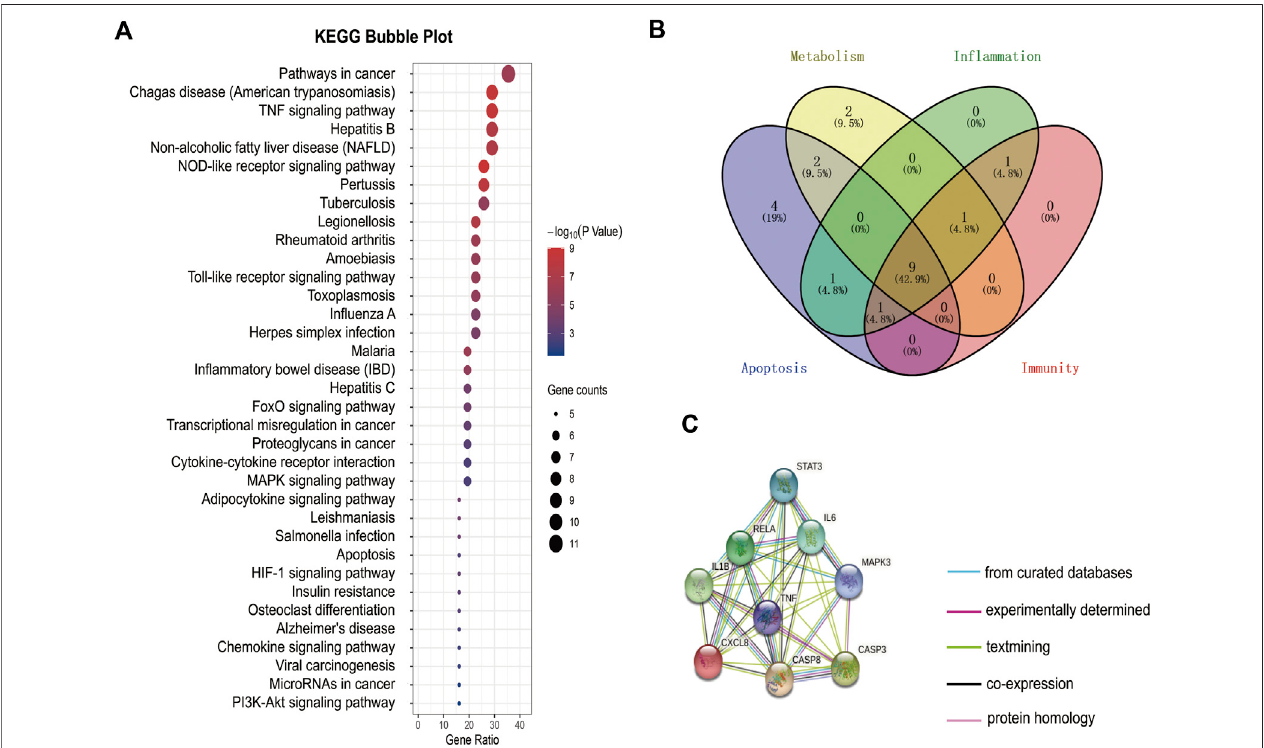
FIGURE 3 | Drug – compound – target – disease network